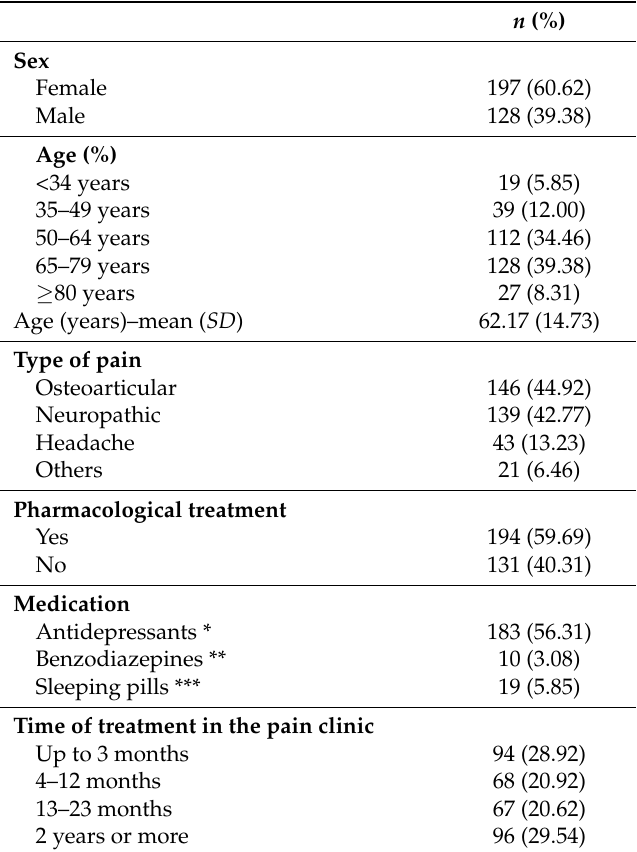
Table 1. Characteristics of the patients examined.